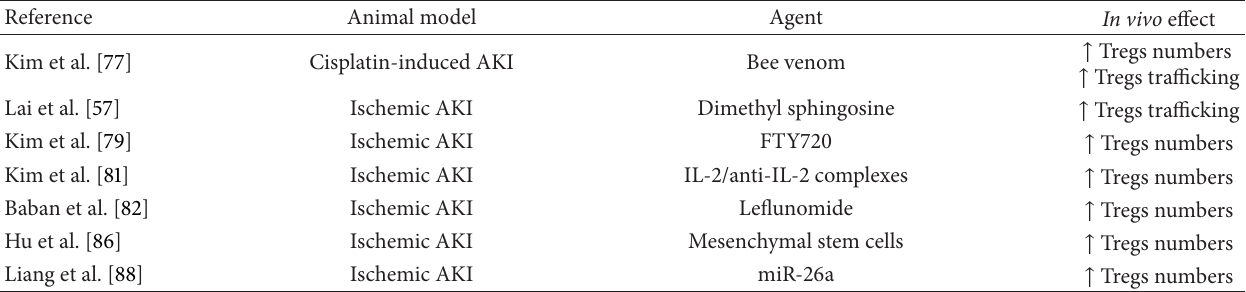
Table 1: Therapeutic strategies for AKI based on intrinsic